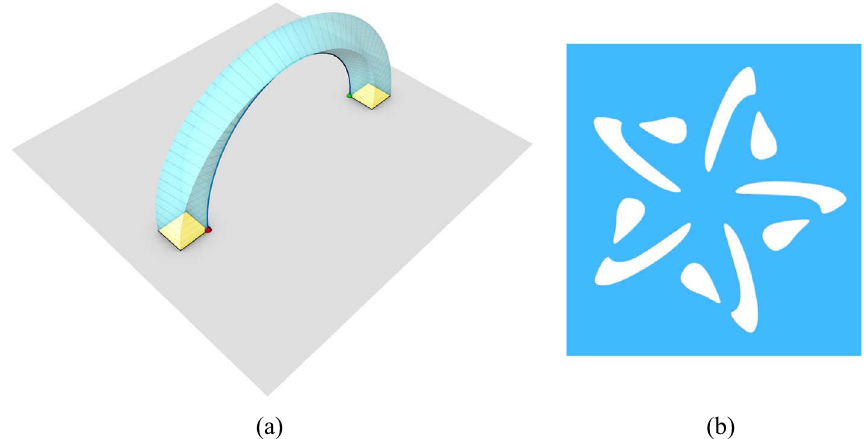
Figure 6. (a) Upper half of GML meeting Flatland, with the green and the red dot connected via a rib. (b) Architon (Fig. 4) moving through a cone.